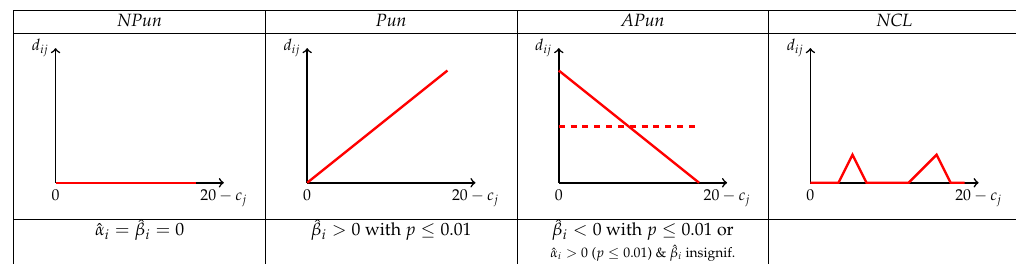
Figure 1. Stylized illustration of punishment types.